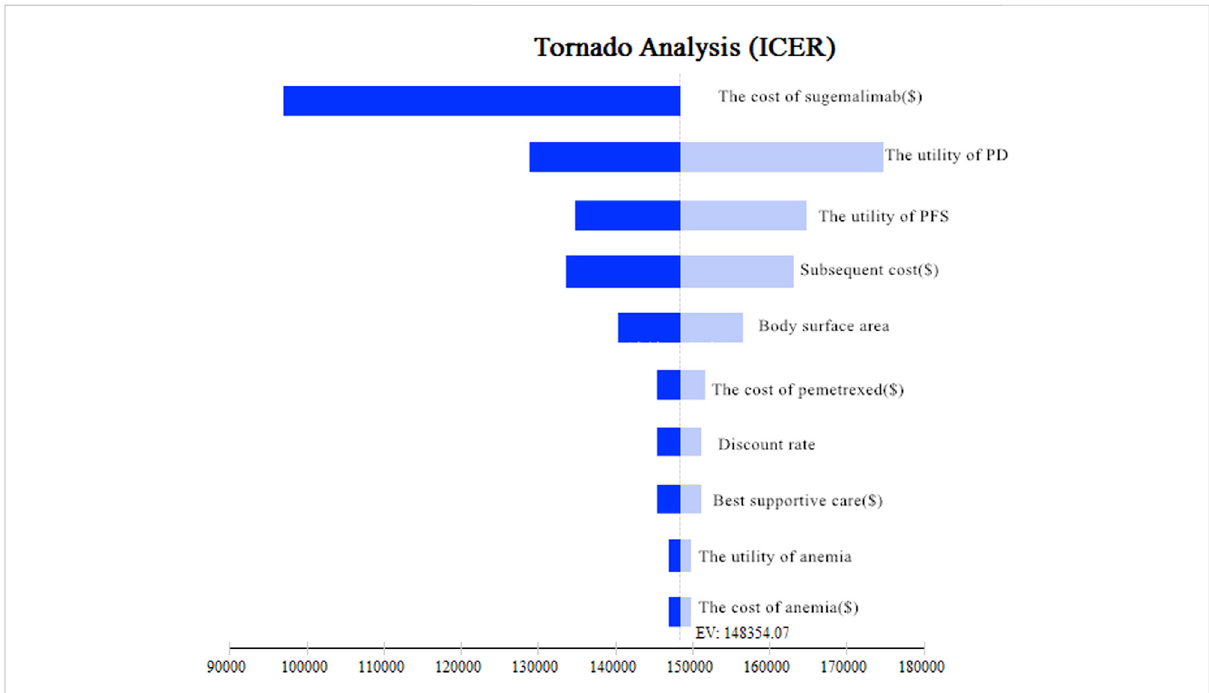
FIGURE 2 Tornado diagram of one-way sensitivity analyses of sugemalimab vs.